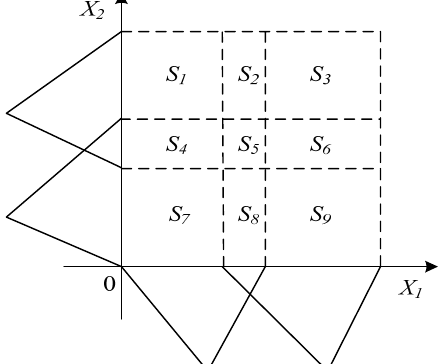
Fig. 2. An example of grid partition method with two input